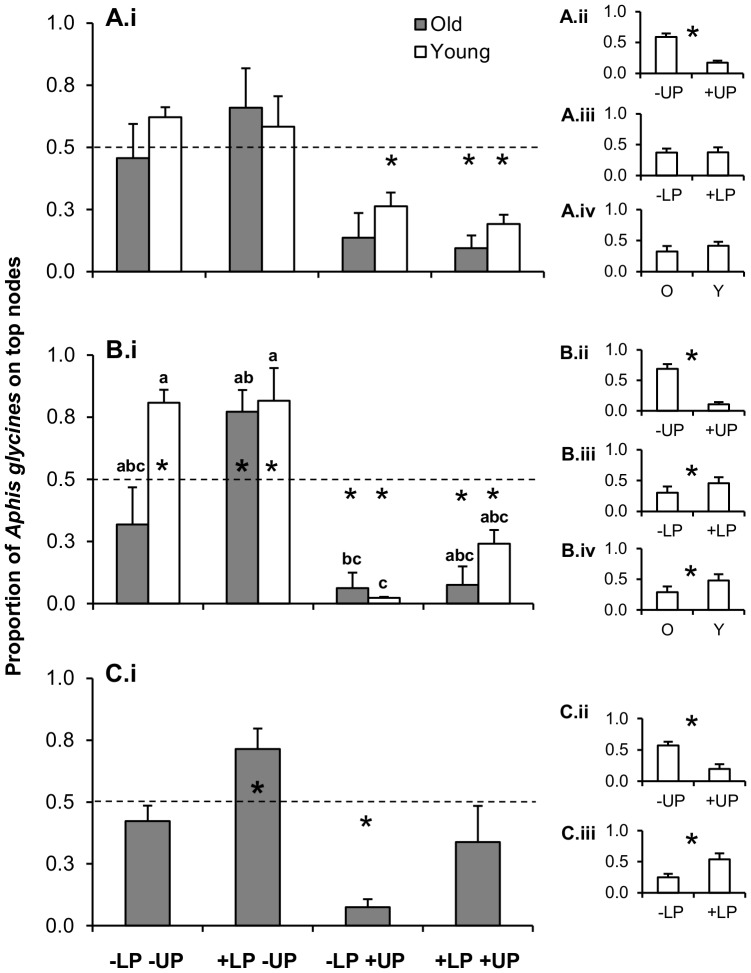
Top-down and bottom-up effects on aphid within-plant distribution.Top-down controls were manipulated as upper predation (ambient levels = +UP, or exclusion = −UP), and lower predation (ambient levels = +LP, or exclusion = −LP) (see Figure 1 for cage designs); bottom-up controls were manipulated using plants of different age (old = O, grey bars; or young = Y, white bars, plants). We present means (+1 SE) of the proportion of A. glycines on the upper nodes of the plants for trials 1 (A), 2 (B), and 3 (C). Means that do not share letters are significantly different (P<0.05, LSMD-TK tests). The dashed line indicates equal proportion at the upper and lower nodes of the plant, and asterisks above and below the line indicate significant departure from equality, testing the alternative hypothesis of different than 0.5 (controls −LP−UP, and +LP+UP), smaller than 0.5 (−LP+UP) or greater than 0.5 (+LP−UP), using t-tests (P<0.05). Small graphs (ii – iv) at the right of the main graphs (i) indicate main effects; asterisks indicate significant differences (P<0.05, ANOVA main effect tests, see
Table 1
).